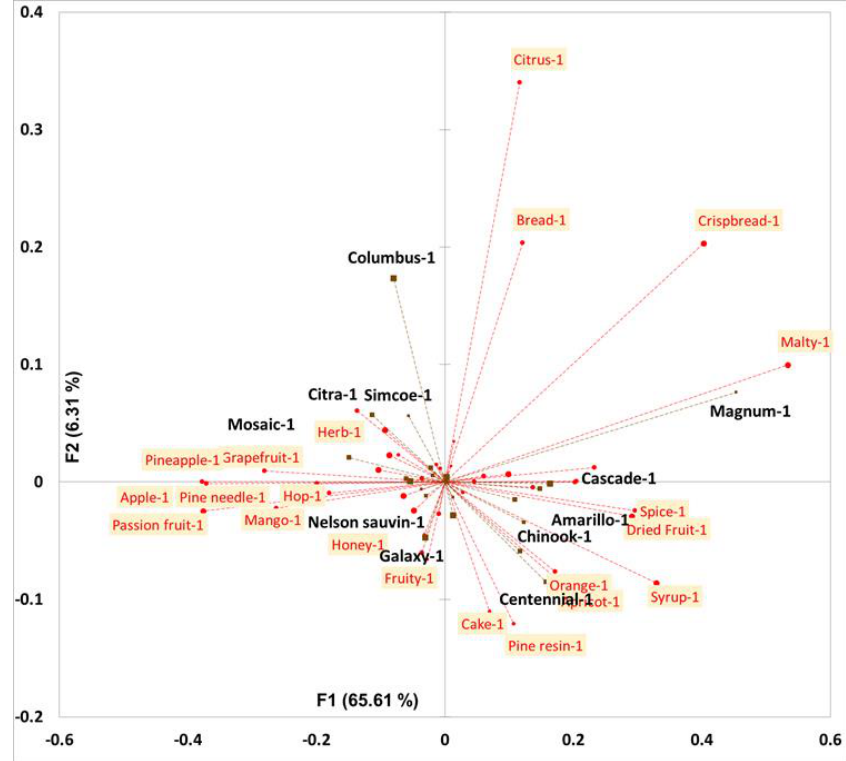
Figure 6. Map of categories projecting the coordinates from the sensory attributes (red) and the presence of hops as supplementary data (black). F1 — first dimension, F2 — second dimension